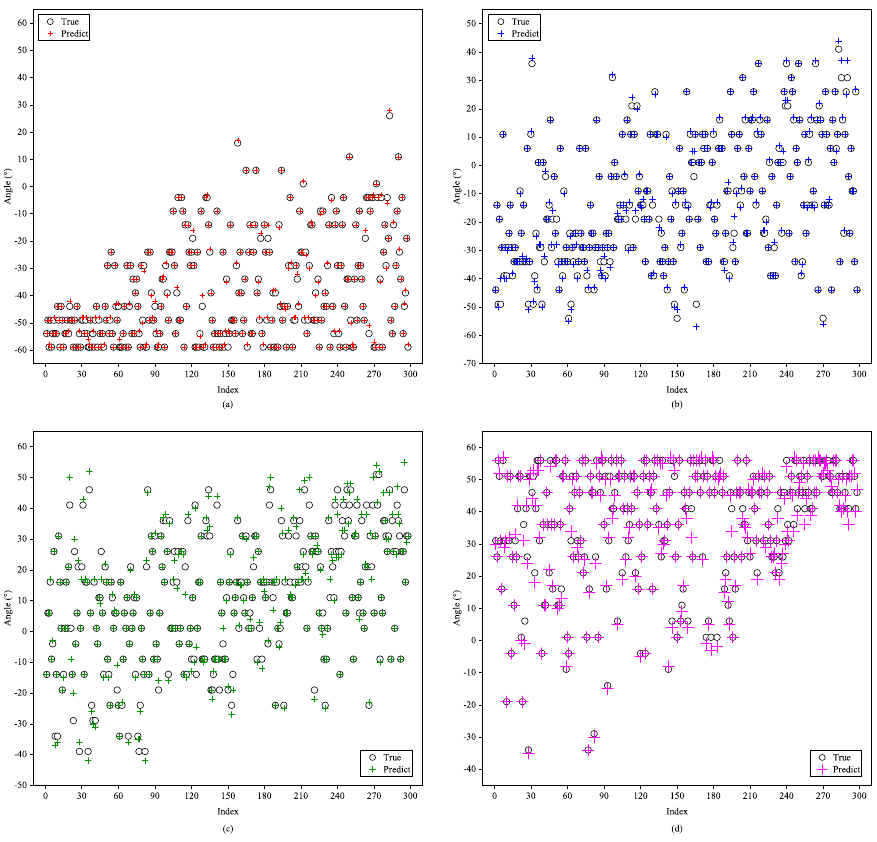
Figure 11. Testing of the proposed A-CRNN model to four-signal testing samples while trained in three-signal case: ( a ) the first signal, ( b ) the second signal, ( c ) the third signal, and ( d ) the fourth